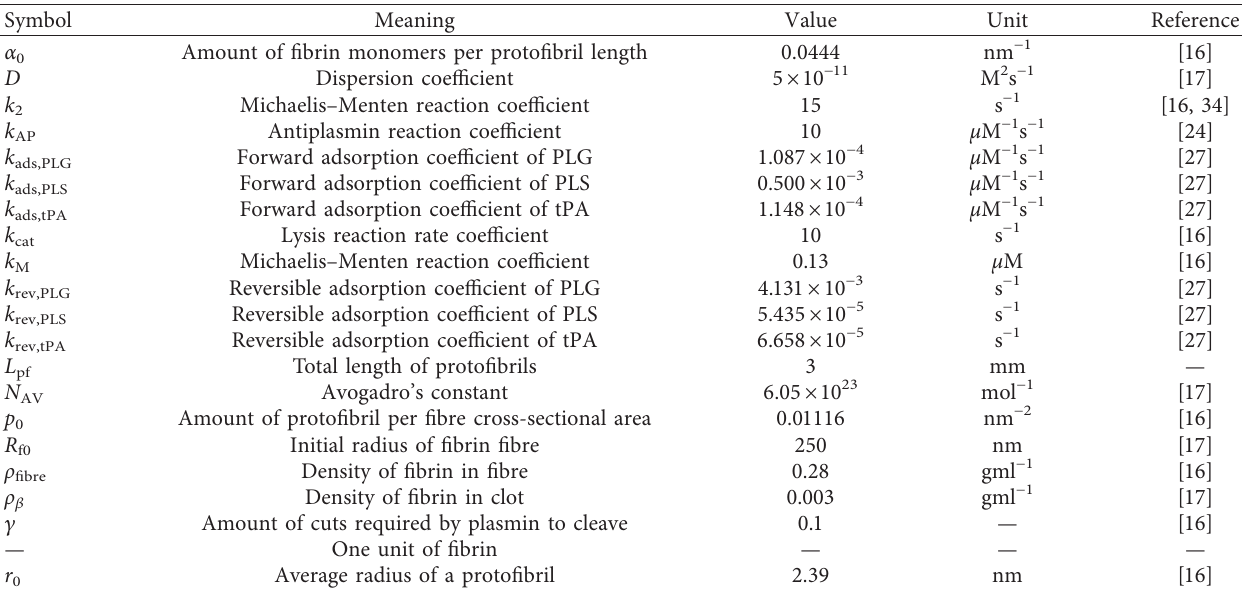
Table 1: Nomenclature.